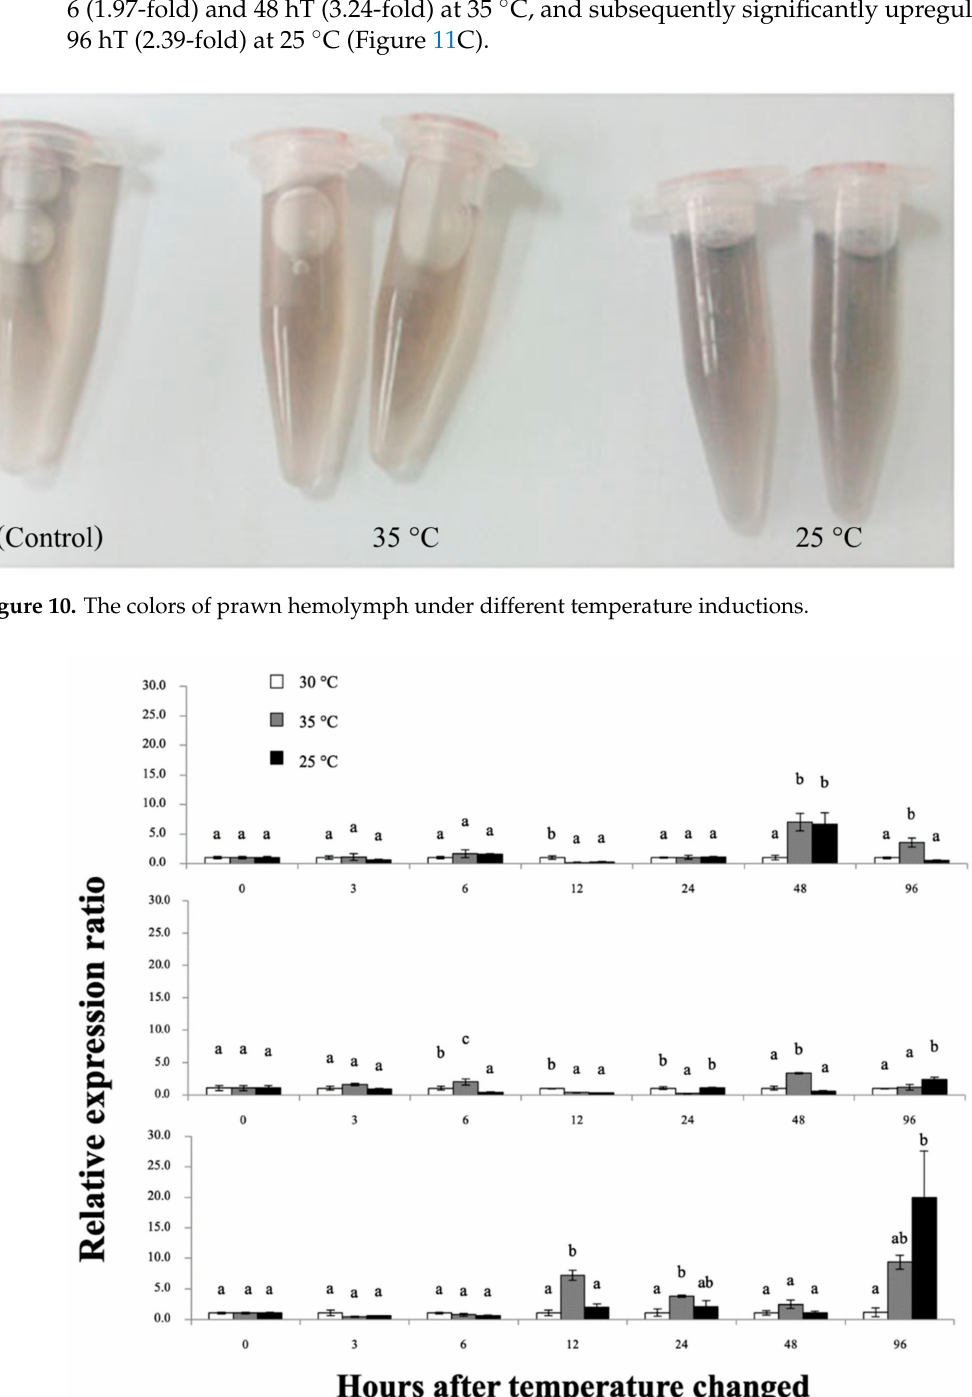
96 hT (2.39-fold) at 25 ◦ C (Figure 11C).